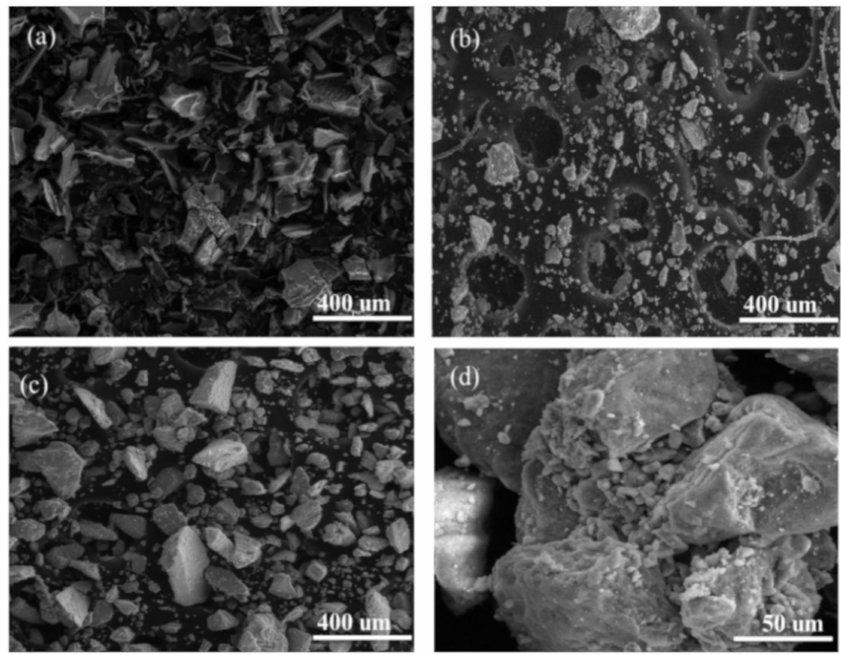
Figure 3. Scanning electron microscopy (SEM) image: ( a ) horseradish peroxidase (HRP); ( b ) ∆ -FeOOH particles; and ( c , d ) ∆